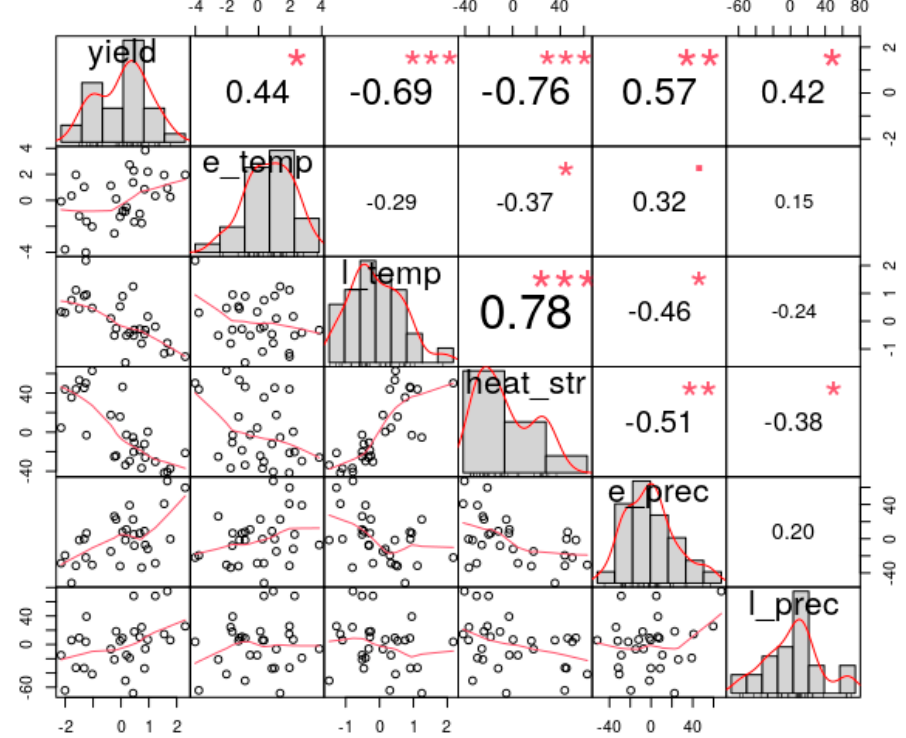
Figure 12. Correlation matrix for the West region for the period 1990–2019. The distribution of the variables is in the diagonal, the correlation diagrams are shown in the lower triangle, and the linear correlation coefficients in the upper triangle of the graph. The font size of the numbers expresses the strength of the correlation. The significance levels are <0.05 (*), <0.01 (**), and <0.001 (***). Table 4. The best models for the period 1990–2019 (t means t-value).